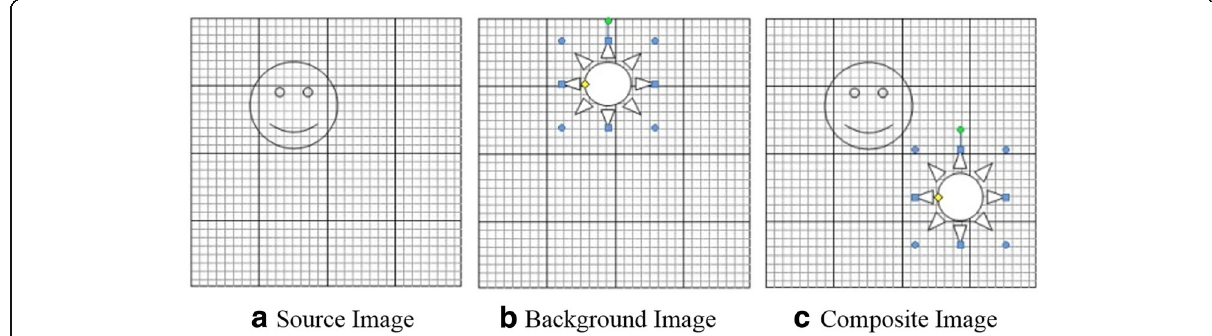
Fig. 1 a – c Tampering showing aligned and nonaligned double JPEG